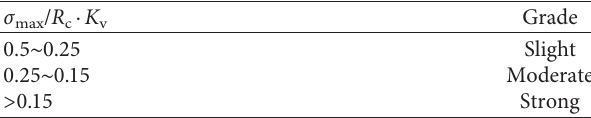
Table 4: Classification criteria of deformation [41].